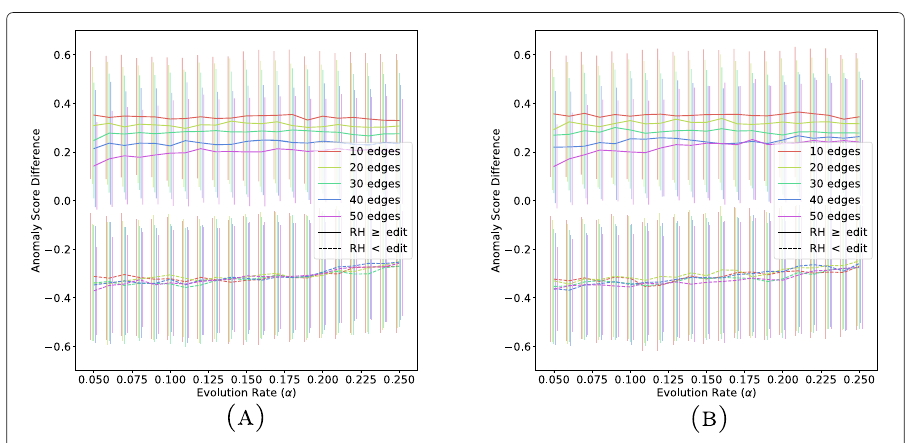
Fig. 11 Difference between edit distance and RH distance. a Bump Power-Law Scan. b Bump Power-Law Lateral